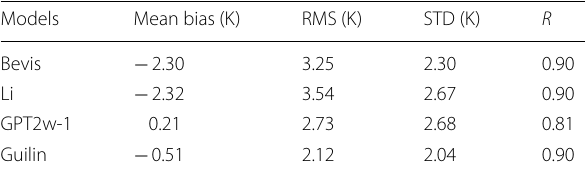
Table 2 Statistical results of the mean bias, RMS and STD for the four models over Guilin using ERA5 data from 2017 Models